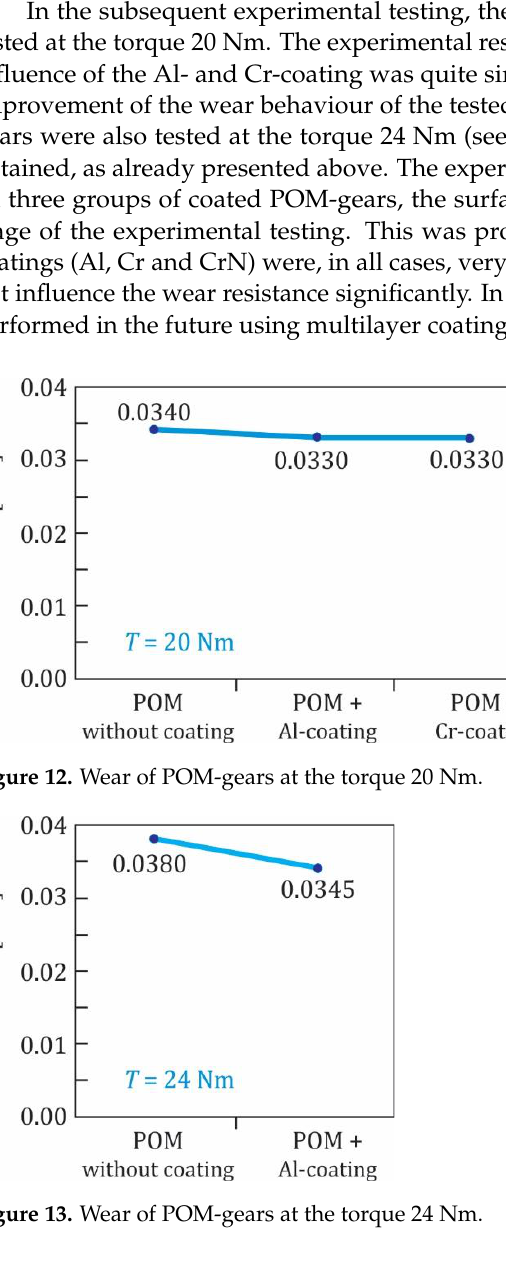
Figure 11. Wear of POM-gears at the torque 16 Nm.